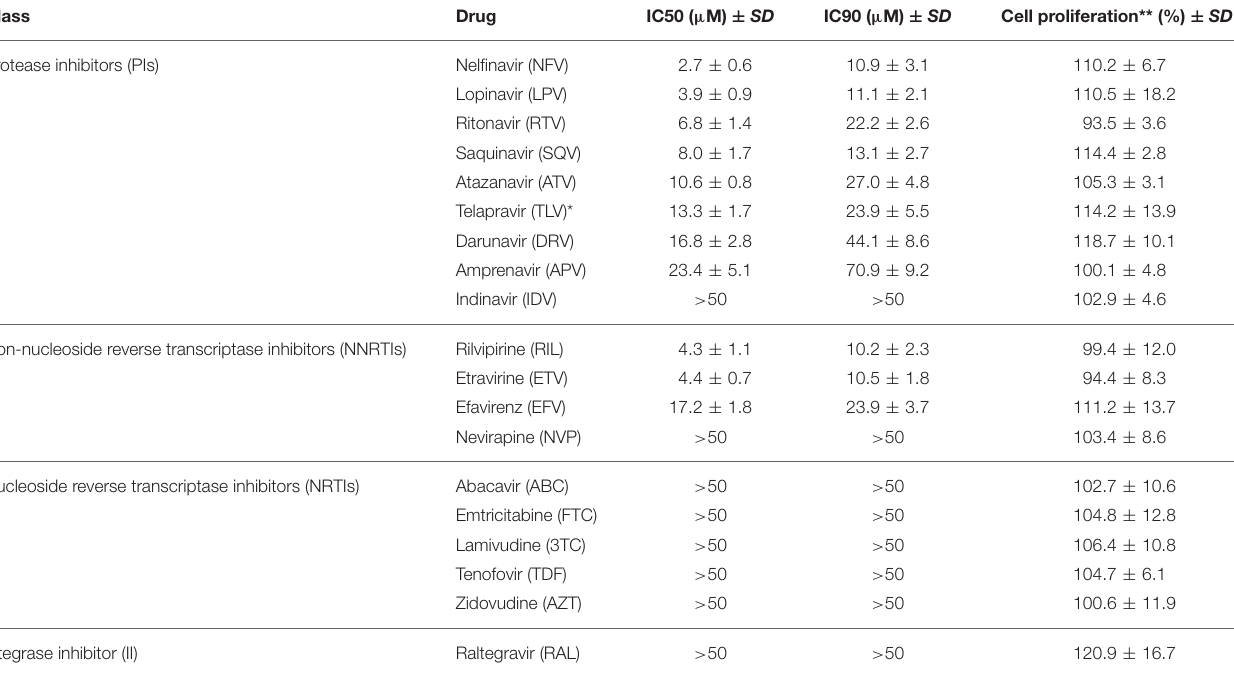
TABLE 1 | Activity of antiretroviral drugs on overall P. berghei in vitro hepatic infection.